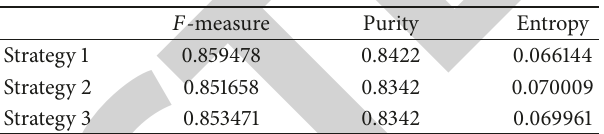
Table 6: The results of document clustering on different strategy for computing the weight of the implicit concepts of the user context ( 𝛼 = 0.05 and 𝛽 = 0 ).